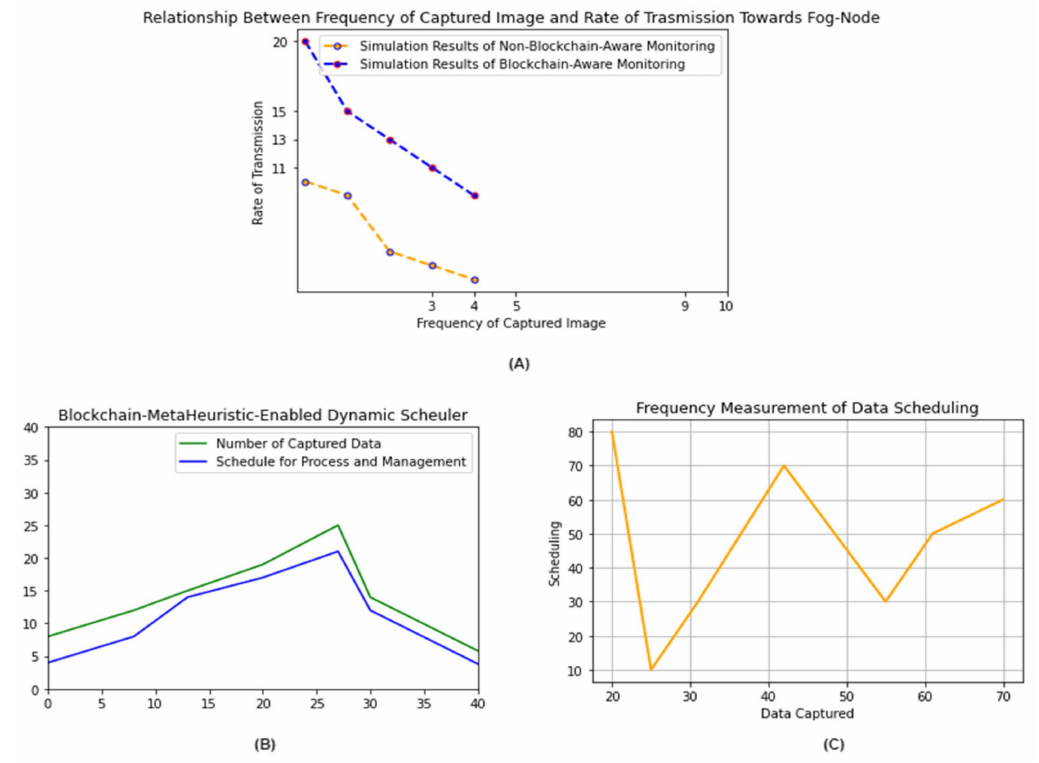
Figure 8. Fog-Based System Evaluation. ( A ) is the Relationship Between the Frequency of Captured Image and the Rate of Trans- mission Towards Fog Node, and ( B ) is the Blockchain-MetaHeuristic (Genetic Algorithm) Enabled Dynamic Scheduler Analysis and Align for Processing, and ( C ) is the Measurement of Frequency of Data Scheduling and Analysis the Actual